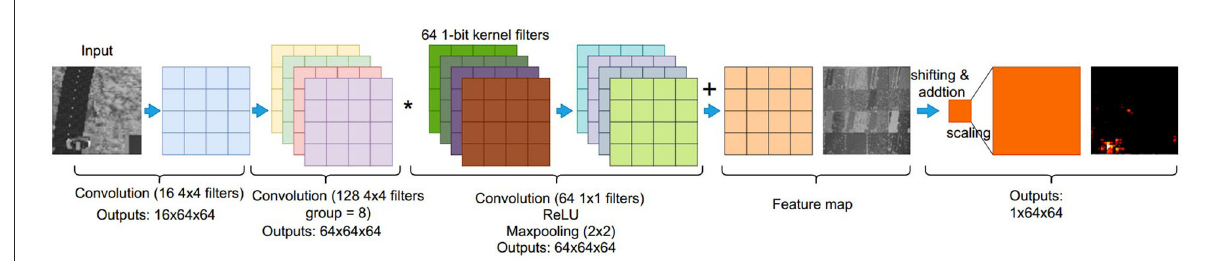
FIGURE7 An overview of an on-sensor fully convolutional network (FCN) architecture and inference process using a PPA for heat map generation. A three-layer FCN architecture is used in our study. The first convolutional layer can be seen in Figure 5 in detail. In the second convolutional layer, 128 convolutional kernel filters are applied to the 16 input binary feature maps from the first layer, generating 64 feature maps with a convolution group setup of eight. The fusion of intermediate extracted features is implemented by addition within each group. The third layer uses binary filters with a size of 64 × 1 × 1, hence, the final feature maps can be obtained by “Multiplication” with bit operation based on DREG. The final heat map is generated by combining these input 64 feature maps by shifting and addition operations.